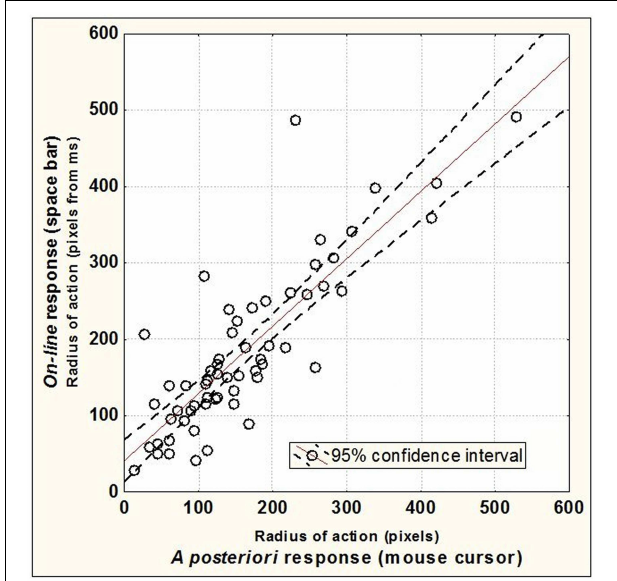
FIGURE 5 | On-line Radius of Action as a function of A posteriori Radius of Action, for each participant; each point corresponds to individual mean data for a given level of the Motion Slope condition (three data points per participant).